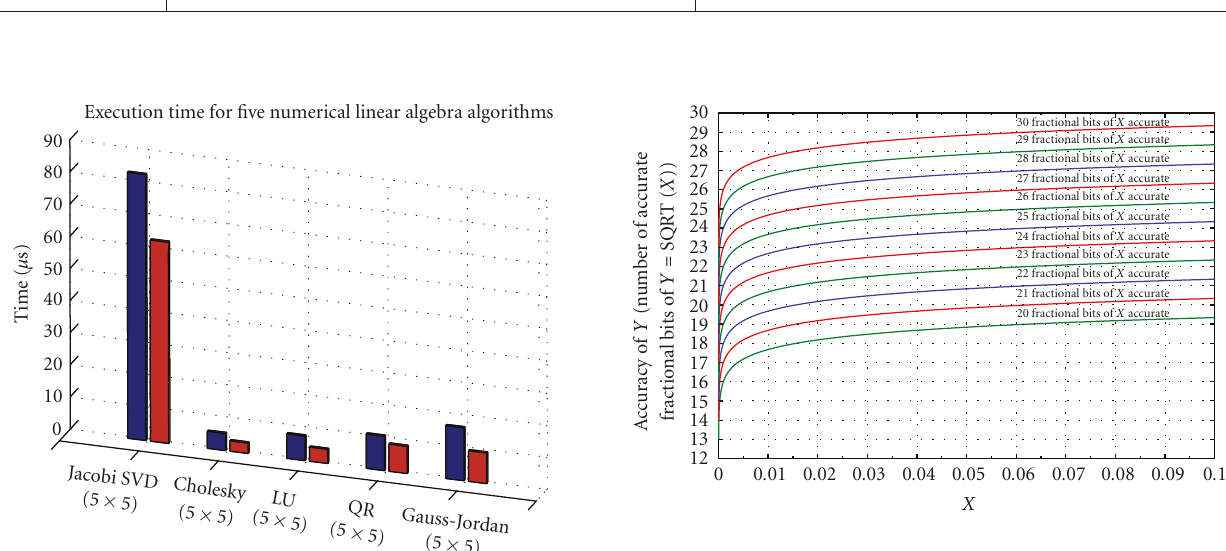
Figure 13: Accuracy of square root calculation SQRT( x ) depends on accuracy of the operand x